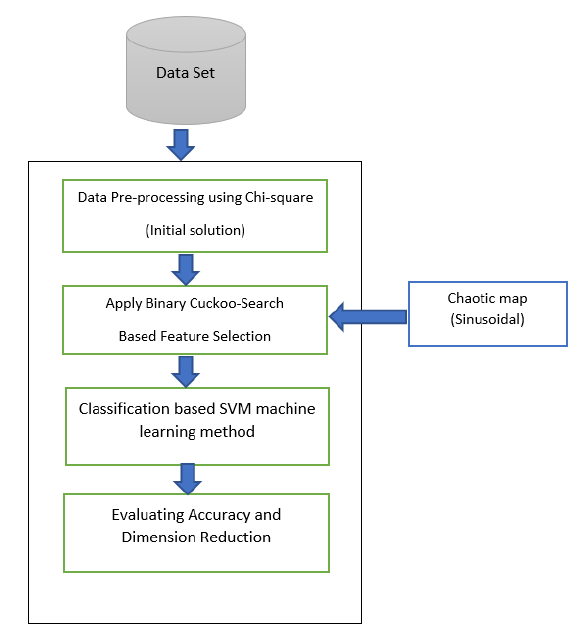
Fig. 1. Location of the KVMRT